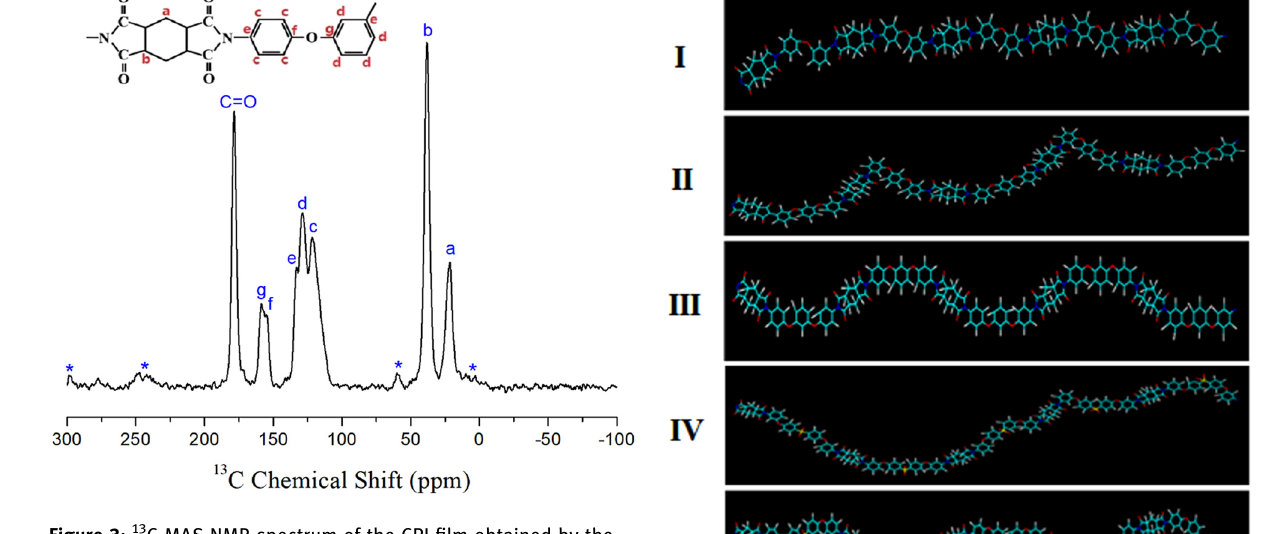
Figure 3: 13 C MAS NMR spectrum of the CPI fi lm obtained by the reaction of CHDA with 3,4 - ODA. The spinning sidebands for the benzene ring and C ] O are marked with asterisks ( * ) .